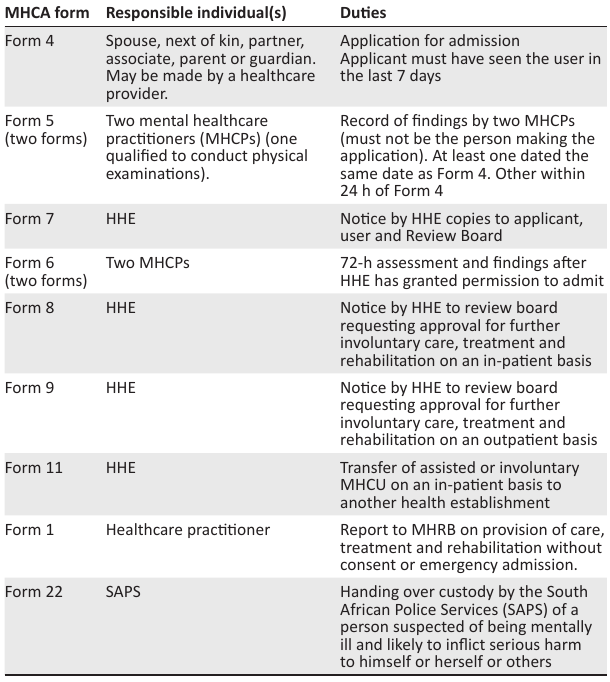
TABLE 4: Mental Health Care Act forms for assisted and involuntary